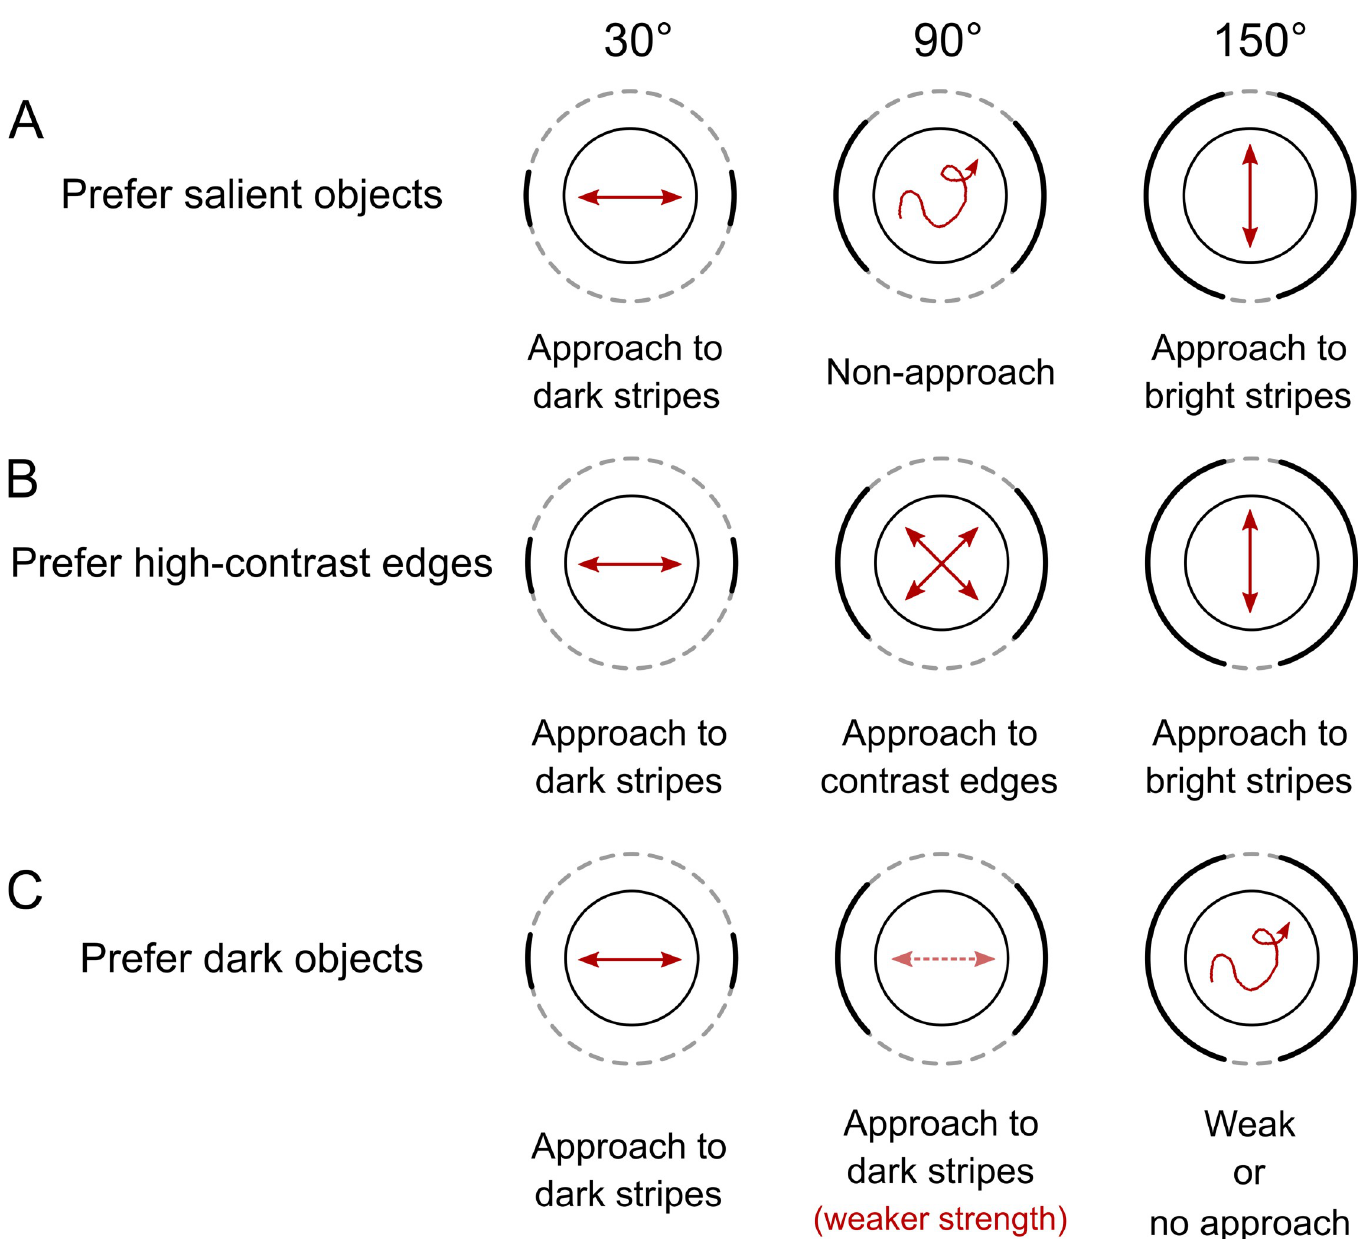
Fig 2. Three hypotheses for the approach behavior. (A) The saliency hypothesis. If the wing-shortened flies prefer salient objects, the movement would approach visually salient objects (left: dark stripes, right: bright stripes). The flies would not perform approach behavior when the dark and bright stripes are equally large (middle). (B) The contrast hypothesis. If flies are attracted by high-contrast stimuli, they would approach either narrow dark stripes (left) or narrow bright stripes (right) just as in the saliency hypothesis. However, when the dark and bright stripes are equally large (middle), the flies would approach the four edges. (C) The shade (negative phototaxis) hypothesis. If the flies prefer dark regions, they would always approach the dark stripes no matter their size (left and middle). However, when the most of the screen is covered by the dark stripes (right), the approach behavior would become weak or even disappear. All three hypotheses predict the same approach behavior in the classical Buridan’s paradigm (right) and the hypotheses can only be tested and verified when the stripes of different sizes are